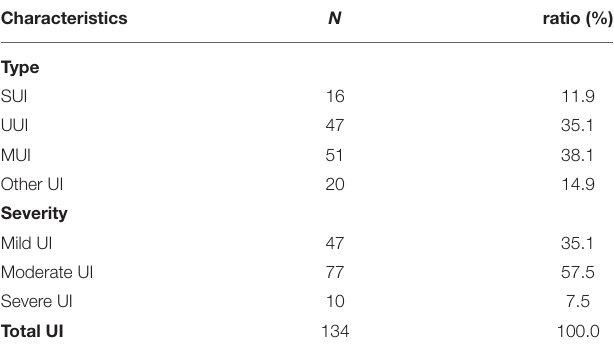
TABLE 1 | General characteristics of older adults in nursing homes. Characteristics